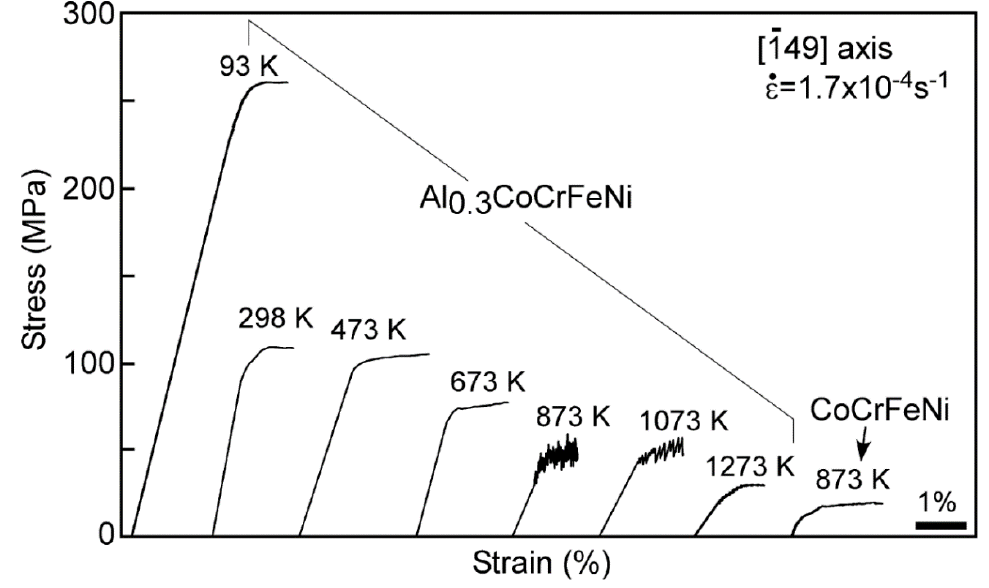
Figure 26. Stress vs. strain curves for the Al 0.3 CoCrFeNi and CoCrFeNi single crystals that were compressed at temperatures ranging from 93 to 1273 K (from −180 to 1000 °C) (reproduced from Reference [191] with permission).